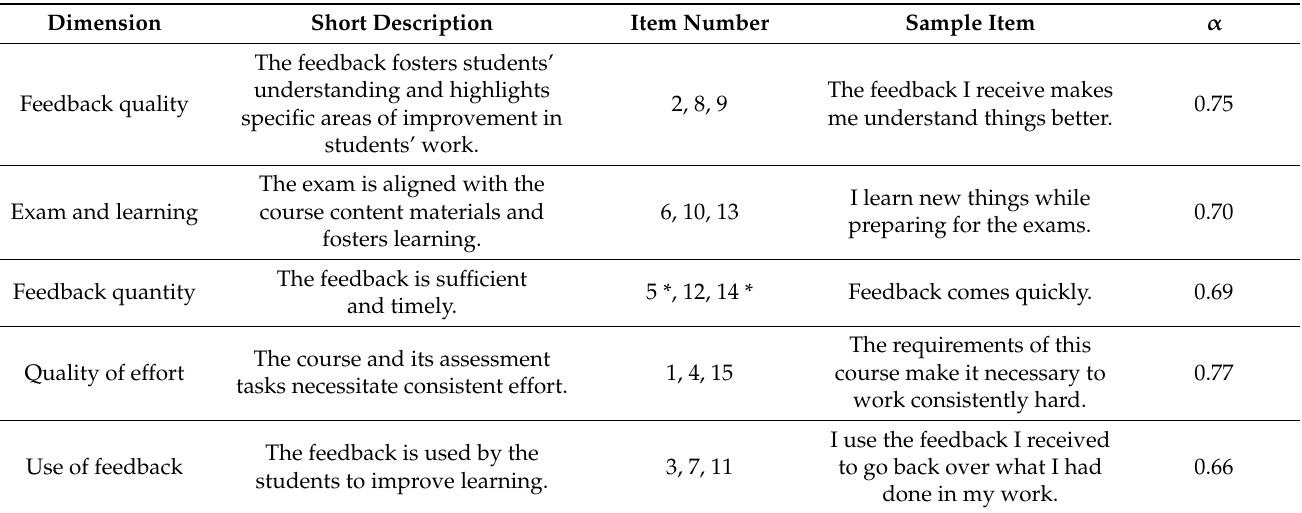
Table 1. Sample items of each dimension of the N-AEQ and the corresponding reliability